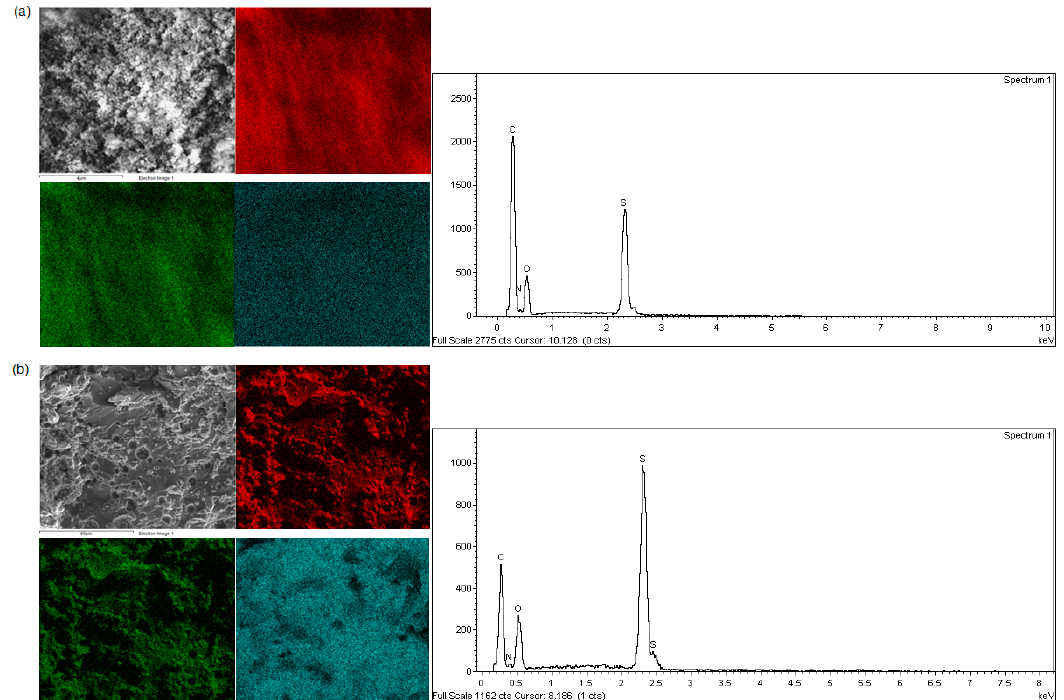
Figure 4. SEM image of polymer P10 at 30,000× magnification.